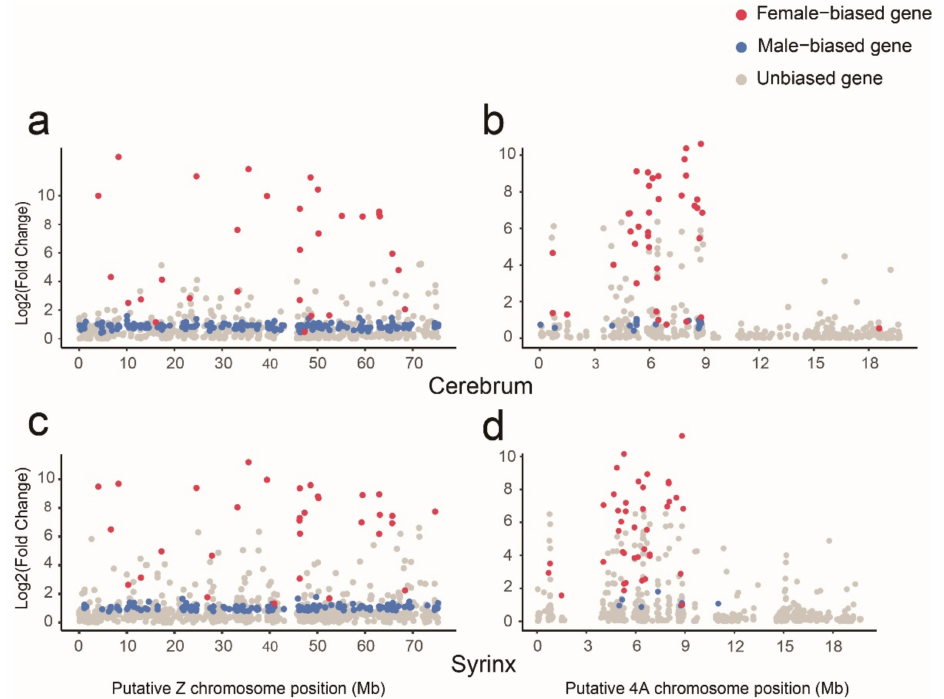
Figure 3. Distribution and expression characteristics of sex-biased genes on chromosomes Z and 4A. The distribution and expression characteristics of the cerebrum (Z ( a ); 4A ( b )) and syrinx (Z ( c ); 4A ( d )) sex-biased genes on chromosomes Z and 4A. The vertical axis represents the difference in gene expression magnitude (Fold Change) between males and females. The horizontal coordinates represent the position of the gene on the putative chromosomes Z and